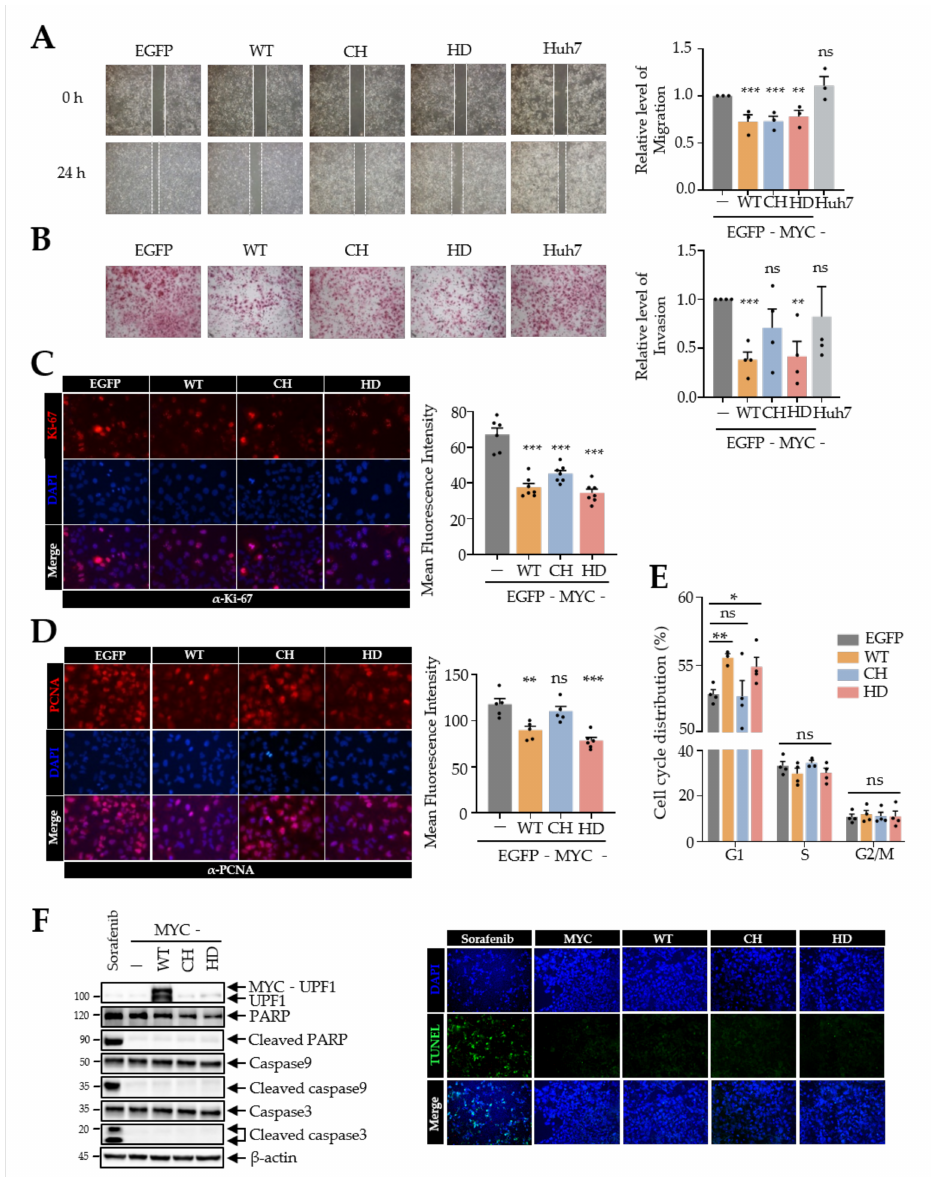
Figure 2. UPF1 variants reduced the tumorigenesis of Huh7 cells. Cell migration assay (100 × magnification) ( A ), cell invasion assay (100 × magnification) ( B ) and immunofluorescence analysis ( C , D ) were performed using Huh7 cells infected with retrovirus expressing UPF1 variants. Im- munofluorescence microcopy showed Ki-67 (red) ( C ), PCNA (red) ( D ) and nuclei (blue) (400 × magnification). Relative levels of migration, invasion, or expression in the assays were quantified. ( E ) The cell cycle distribution in UPF1 variant-expressing Huh7 cells was evaluated by flow cytometry. ( F ) Apoptosis analyses were determined by WB (left panel) and TUNEL assay (right panel) using UPF1 variant overexpressing Huh7 cells (200 × magnification). * p ≤ 0.05; ** p ≤ 0.01; *** p ≤ 0.001; ns, not